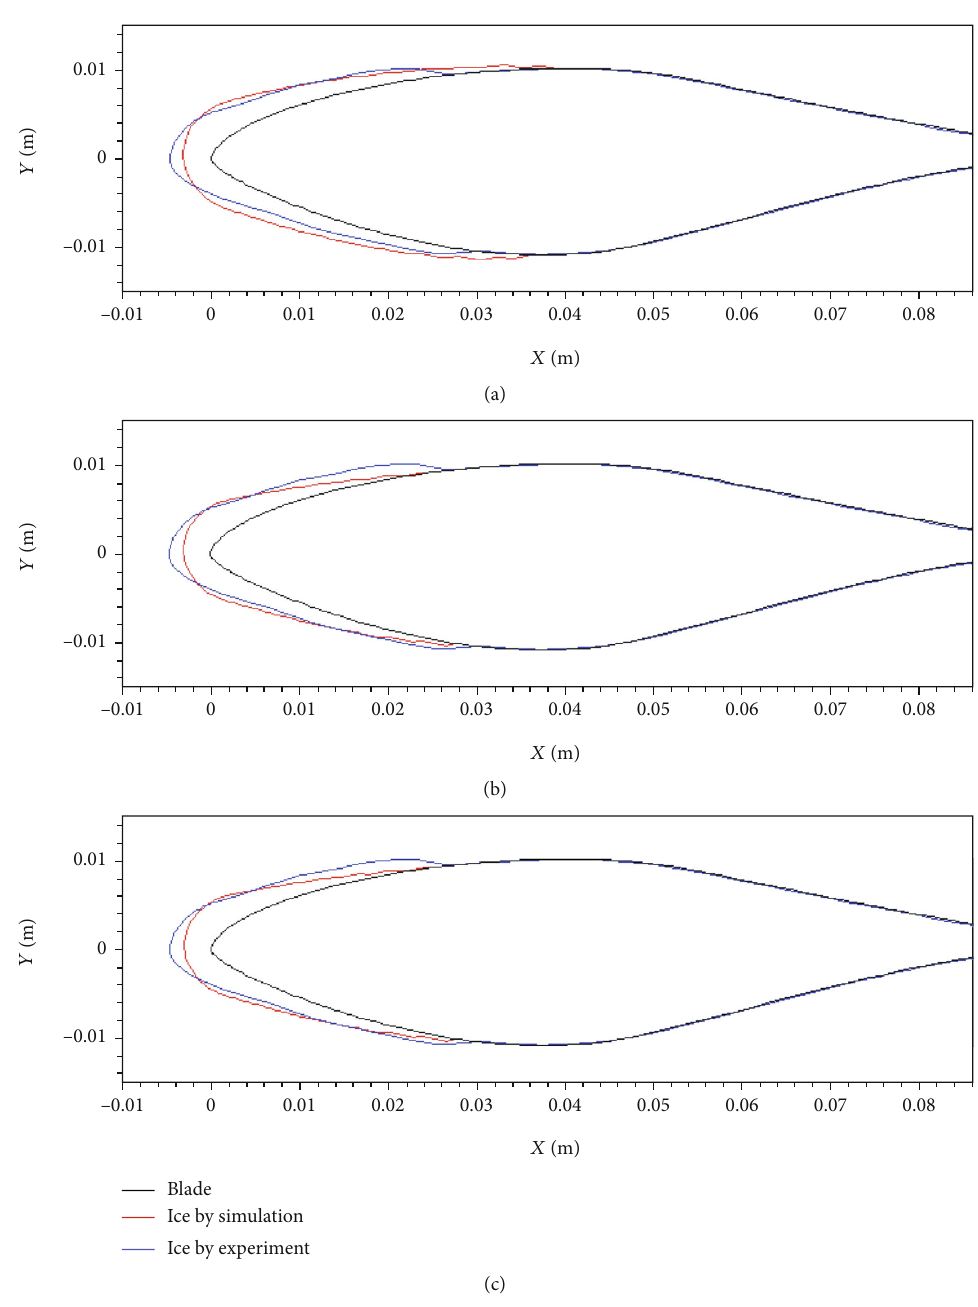
Figure 18: Ice shape comparison of S809 icing: (a) glaze ice, (b) mixed ice, and (c) rime